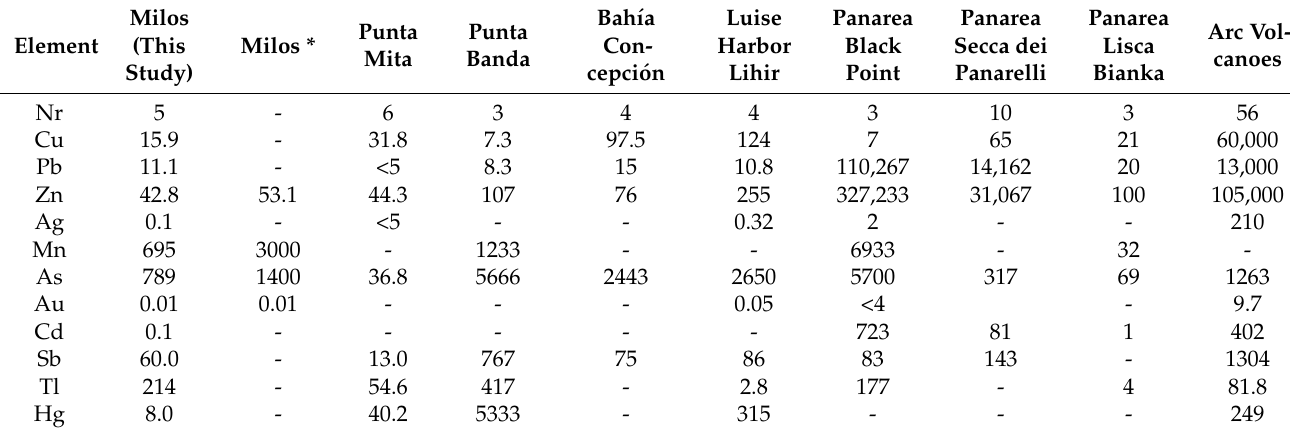
Table 5. Metal Content of samples from Paleochori Bay compared to samples from known sulfide precipitates in various very shallow (and shallow) and to arc volcanic settings elsewhere (all data in